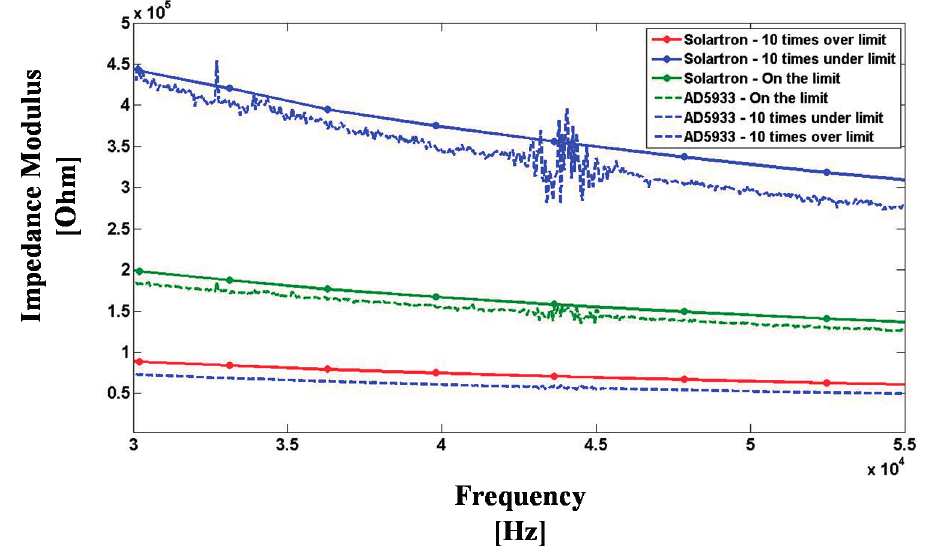
Figure 7. Comparative EIS water quality sensor results obtained using the Solartron Impedance analyzer (solid lines) and the DIS platform (dotted lines), wherein the baseline of 45 ppm nitrate (NO 3 − ), 307 ppm chloride (Cl − ), 199 ppm sodium (Na + ), and 560 ppm sulfate (SO 42 − ) has been used to define the contaminant concentration limit in